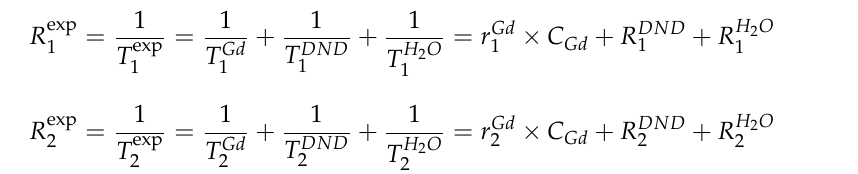
Figure 2. Dependence of the spin–spin relaxation rate R 2 (circles) [16] and the spin–spin relaxation time T 2 (triangles) of water protons in aqueous DND suspensions on the DND concentration.